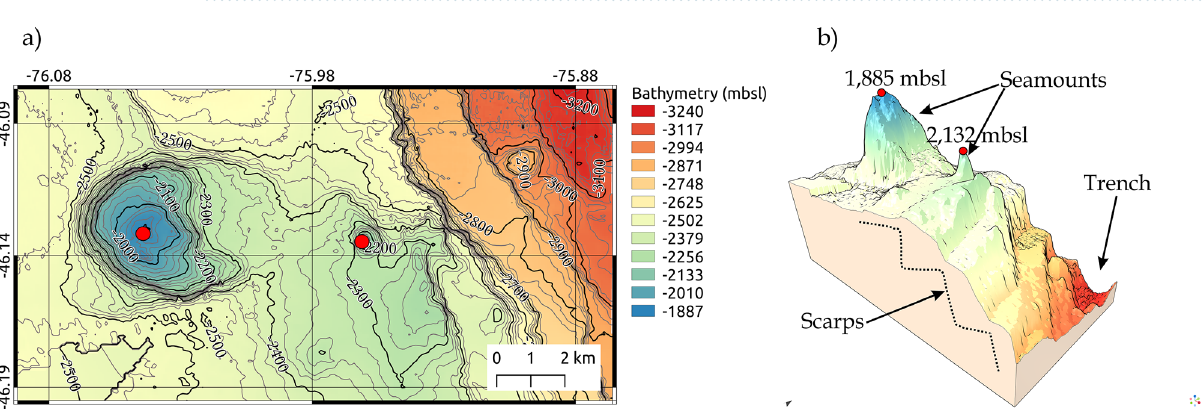
Figure 2. Database map: ( a ) Locations of the new single-channel seismic profiles (bold letters, purple lines) and heat probes measurements (black stars) showed in this study. The other profiles (red, green and sky blue lines) correspond to the database already published and adopted to create the bathymetry grids (based on GEBCO_2019 Grid) and the heat flow compilation reported in Fig. 8. Figure generated using GMT–v6.2.0 (https:// www. gener ic- mappi ng- tools. org/). ( b ) 3-D projection of the high resolution bathymetry collected during MR18-06, showing the location of the two seismic profiles analysed in this study (solid lines), as well as show heat probes piston core measurements (yellow stars) and dredge sampling (red cross), dashed lines correspond to the young volcanic chain (black) and the “ Kepuche ’’ volcano (red). Figure generated using QGIS-v3.16.8 (https:// www. qgis. org/ en/ site/).